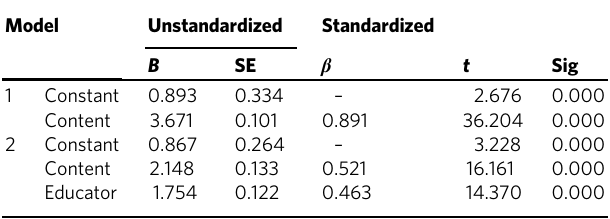
Table 10 State of the coef fi cients of the variables in the multiple regression